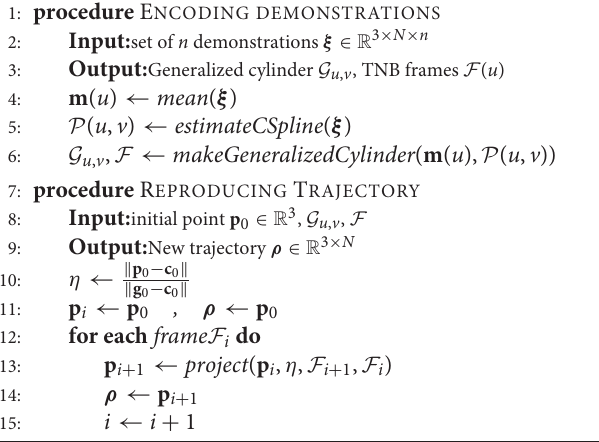
Algorithm 1 Skill Learning using Generalized